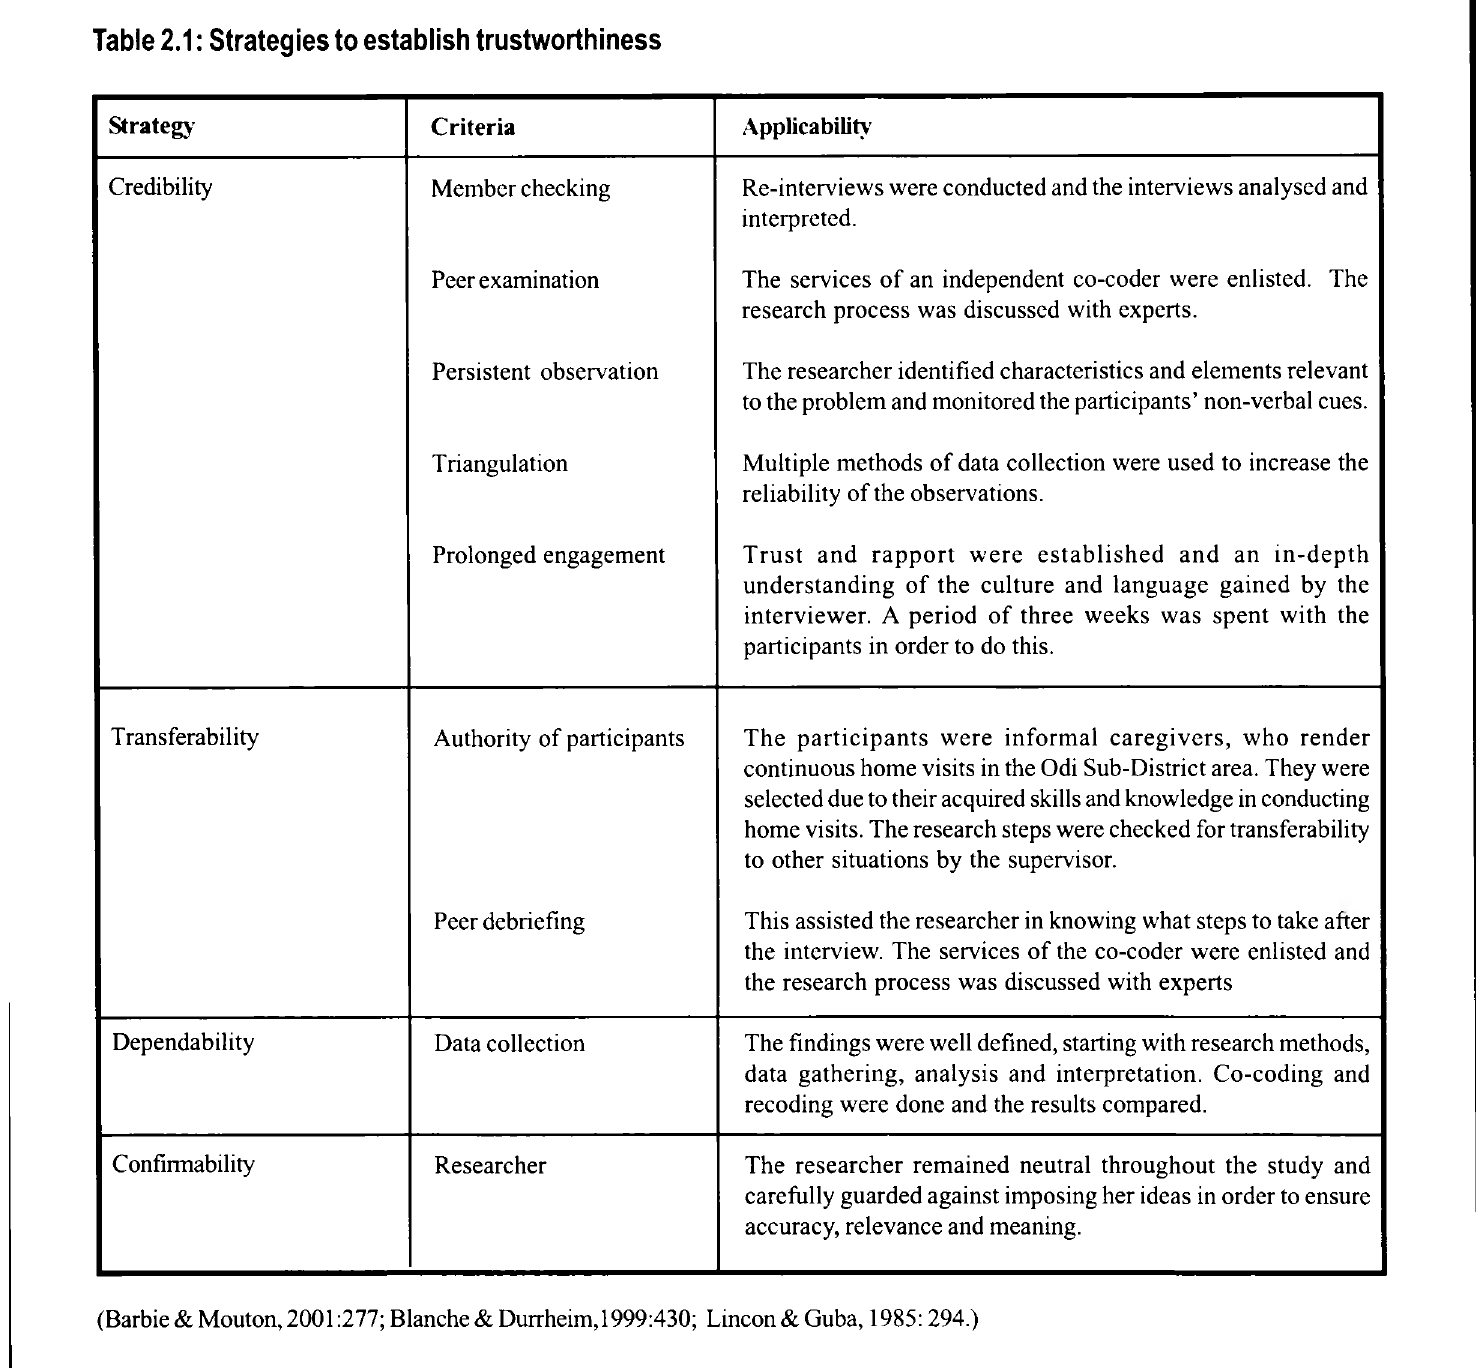
Table 2.1: Strategies to establish trustworthiness